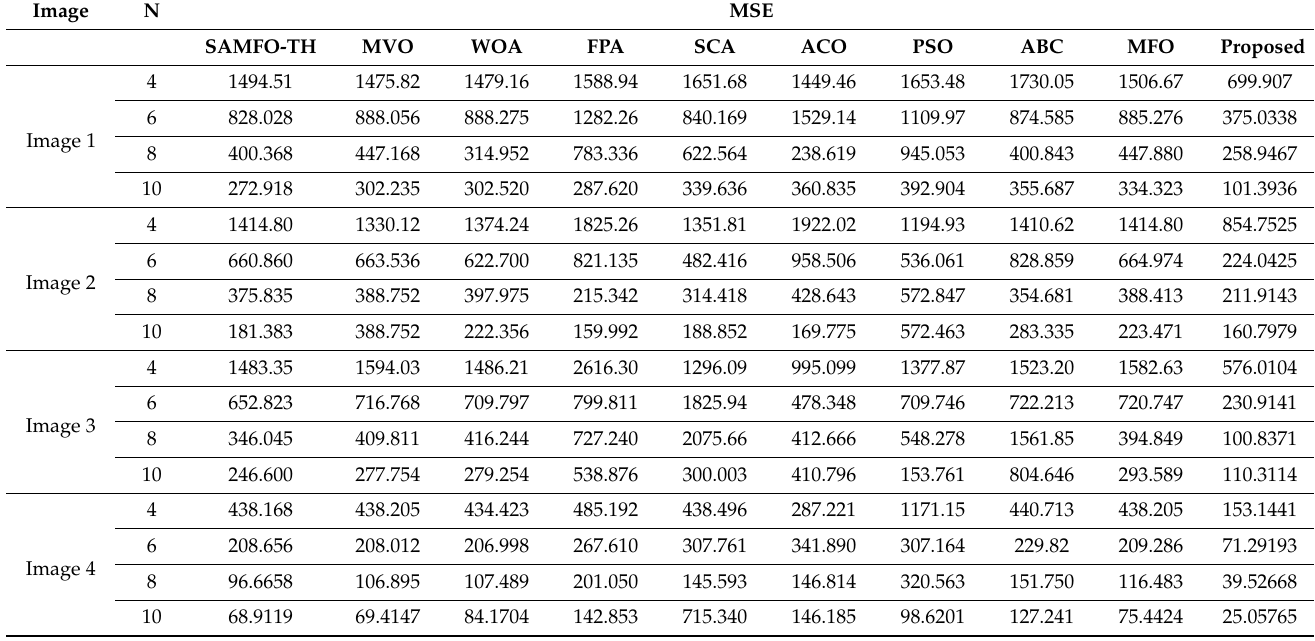
Table 10. Comparison of MSE computed by SAMFO-TH, MVO, WOA, FPA, SCA, ACO, PSO, ABC, and MFO with the proposed model using Otsu’s method with N = 4, 6, 8, and